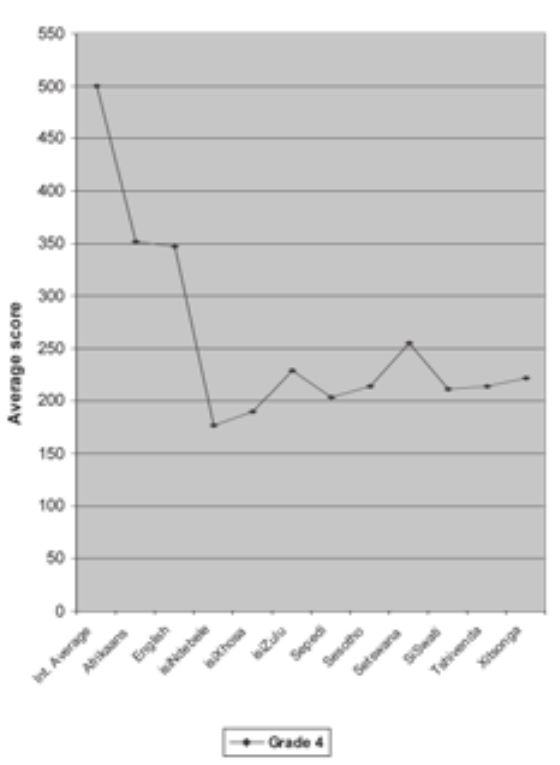
Figure 2: Average achievement according to language for Grade Four